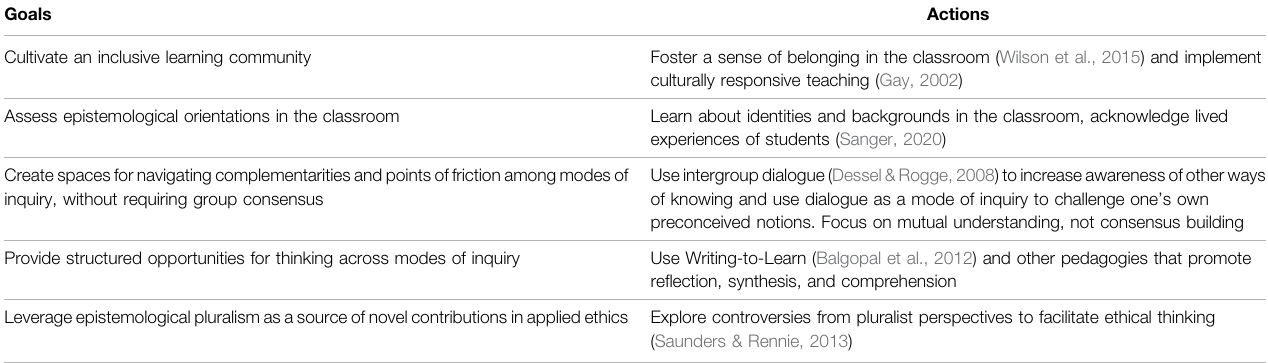
TABLE 1 | Goals and actions in the dialogue-based learning framework. Goals